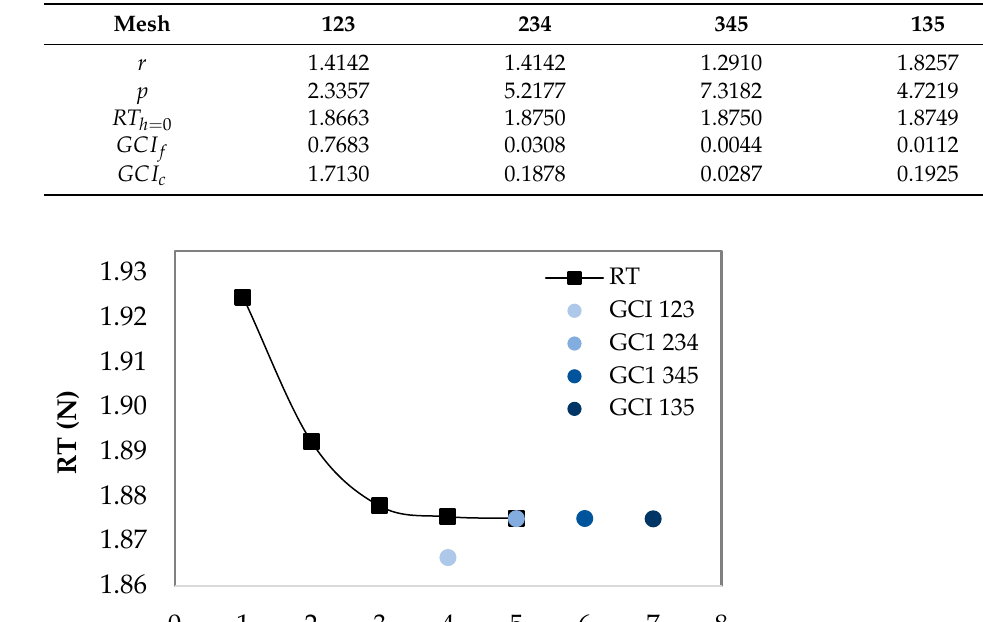
Table 3. Numerical simulation results of vessels w/and w/o